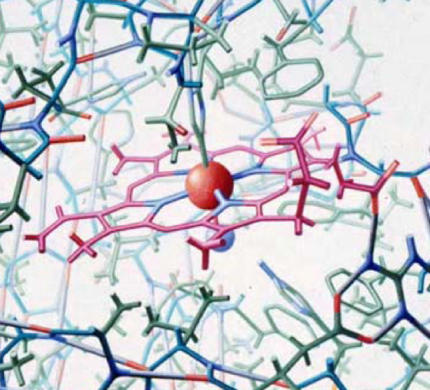
Detail of “Sperm Whale Myoglobin“ by Irving Geis, Showing the Heme Group and Iron IonGeis used many artistic tricks to make this complex figure more comprehensible. This included the use of depth cueing and scaling of bonds to enhance the three-dimensionality of the image so that distant portions are lighter, smaller, and less prominent. Each bond is also carefully rendered so that the shading gives visual clues to its orientation in space. In addition, Geis made small adjustments to resolve any unfortunate overlaps—a process he called “selective lying.” The image was originally published in December 1961 to illustrate Sir John Kendrew's Scientific American article “The Three-Dimensional Structure of a Protein.” The painting is now part of the Irving Geis Collection at the Howard Hughes Medical Institute.